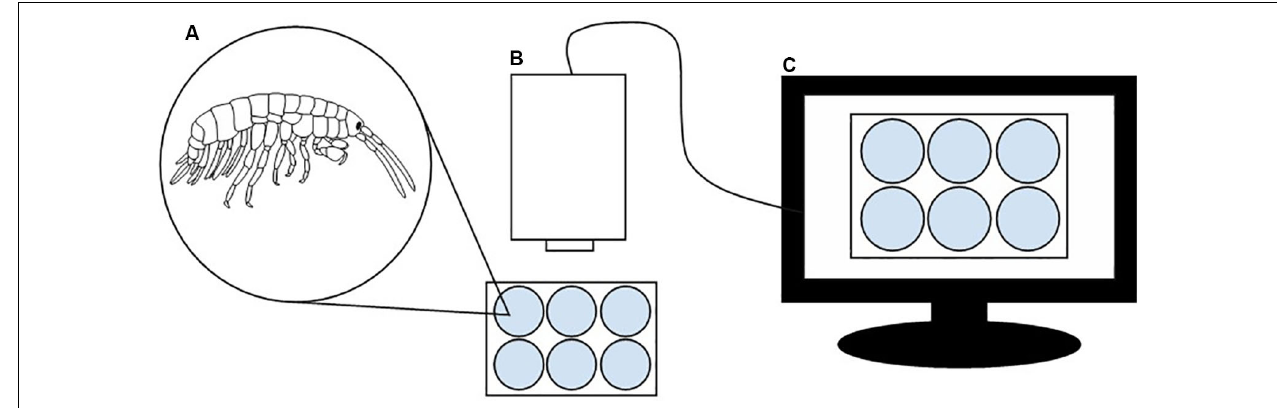
FIGURE 1 | Experimental setup, adapted from Kohler et al. (2018a). Amphipods, one per well and in their holding seawater, in the 6-well plate (A) were tracked in the DanioVisionTM observation chamber by the infrared camera (B) , which was connected to a PC with EthoVision R (cid:13) XT software (C) .